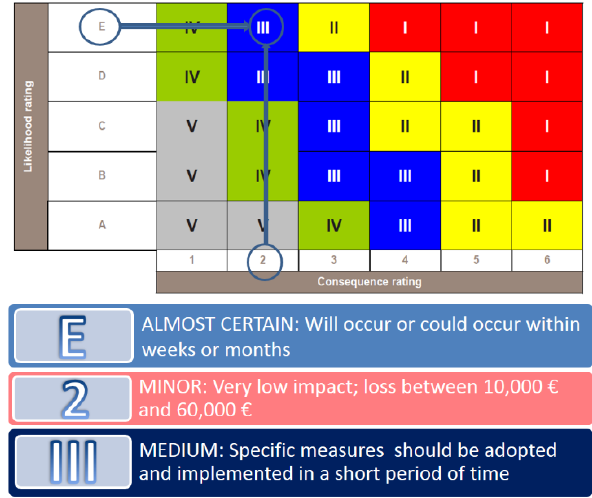
Figure 10. Risk analysis for pollution of underground aquifers.